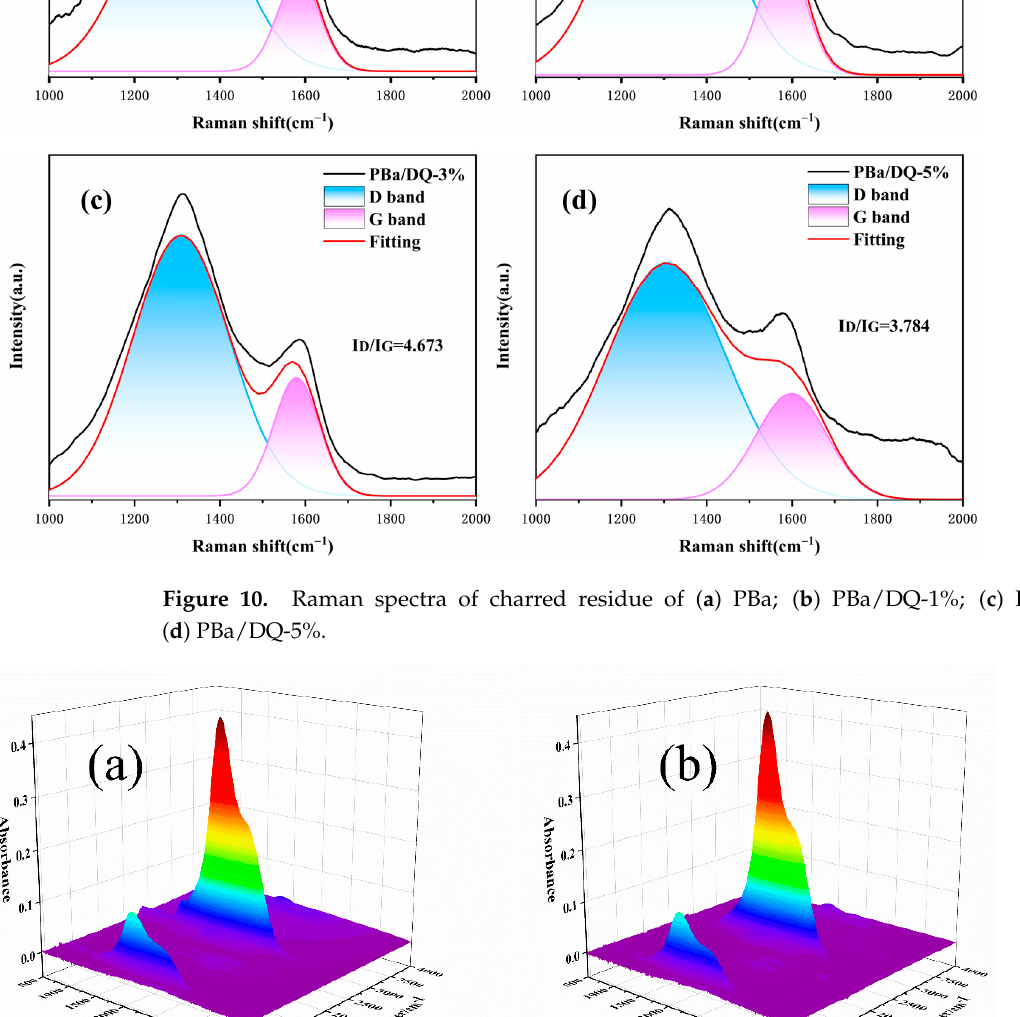
Figure 12. FTIR spectra of ( a ) PBa; ( b ) PBa/DQ-5% at different temperatures. Figure 13. The analysis of pyrolysis products for pure PBa, PBa/DQ-5%: ( a ) water and ammonia gas; ( b ) alkane-containing compounds; ( c ) CO 2 ; ( d ) CO; ( e ) and ( g ) aromatic compounds; ( f ) and ( h ) P– O and P=O compounds. The speculation on FR for the PBa/DOPO-5% composite is illustrated in Figure 14. Once ignition takes place, the DOPO begins to produce char residues due to the highly condensed phase while producing PO radicals that starve the flame of combustible